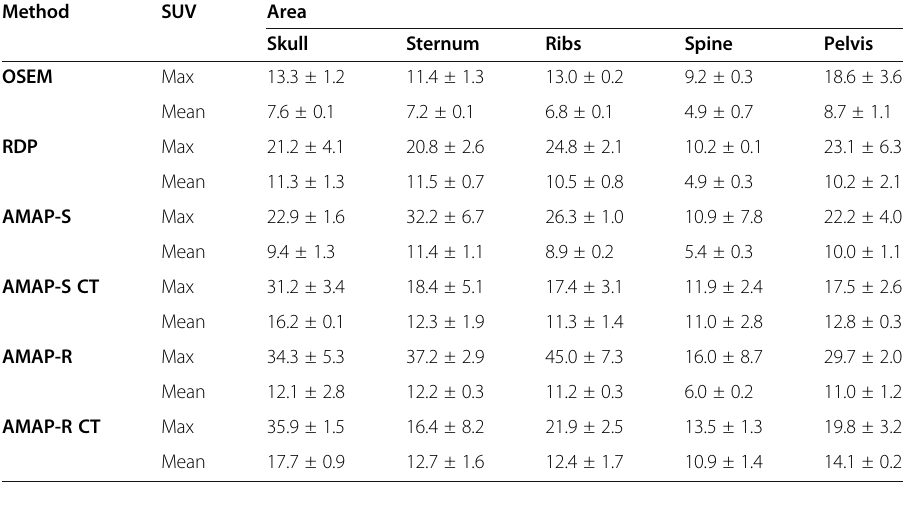
Table 2 SUV max and SUV mean (mean ± standard deviation) for the 4 different reconstruction algorithms. AMAP-S and AMAP-R refer to reconstructions where lesion is absent in the CT and AMAP-S CT and AMAP-R CT to lesion-present